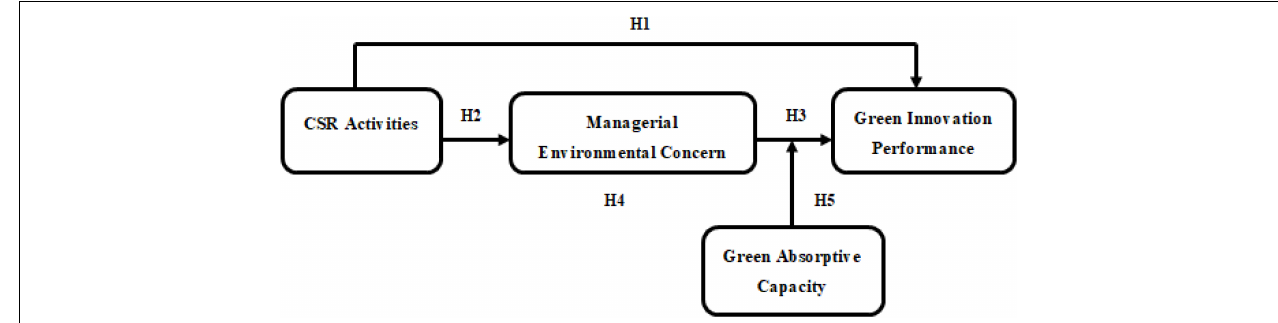
FIGURE 1 | Research